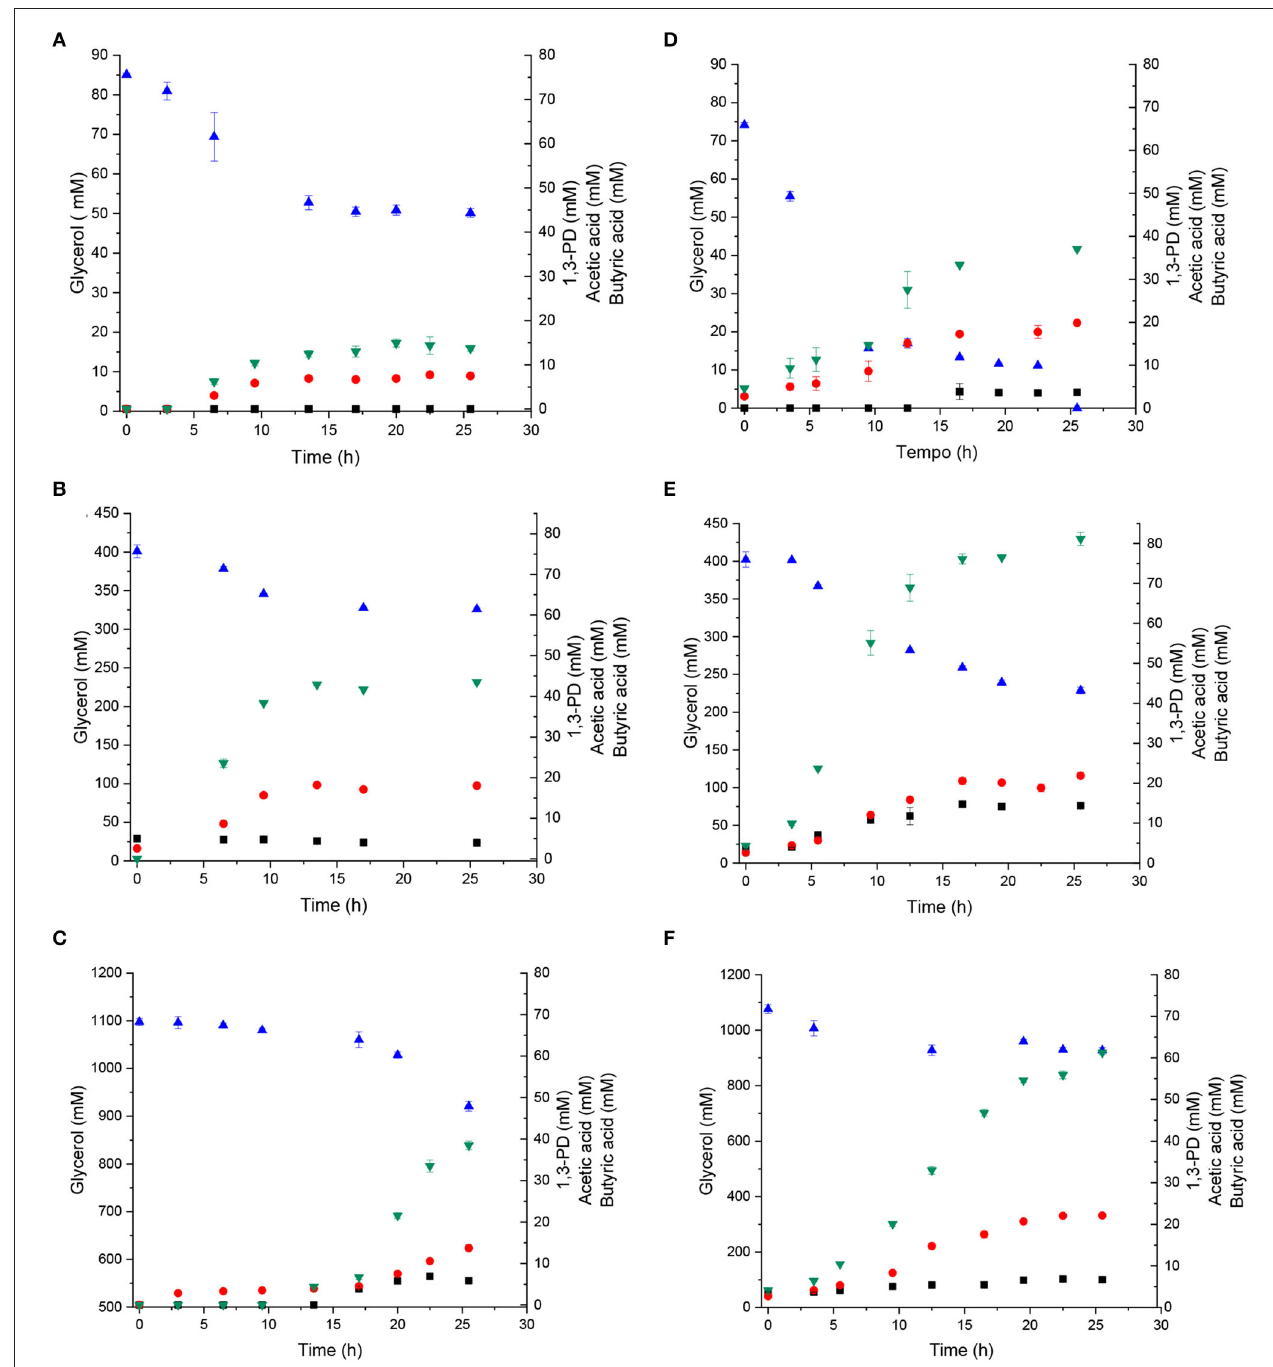
FIGURE 2 | Glycerol and product concentrations during glycerol fermentation by C. beijerinckii Br21 (A–C) and C. pasteurianum DSMZ 525 (D–F) . Glycerol at 80mM (A,D) , 390mM (B,E) , and 1,100mM (C,F) . Glycerol ( ), 1,3-PD ( ), acetate ( ), butyrate ( ).